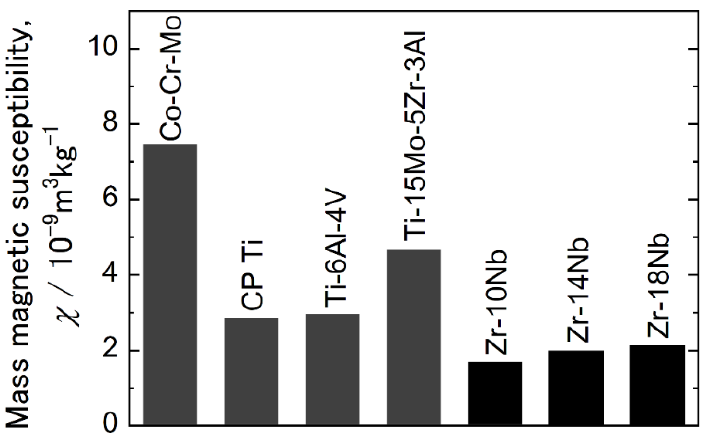
Figure 10. Magnetic susceptibilities of several alloys at room temperature [8].